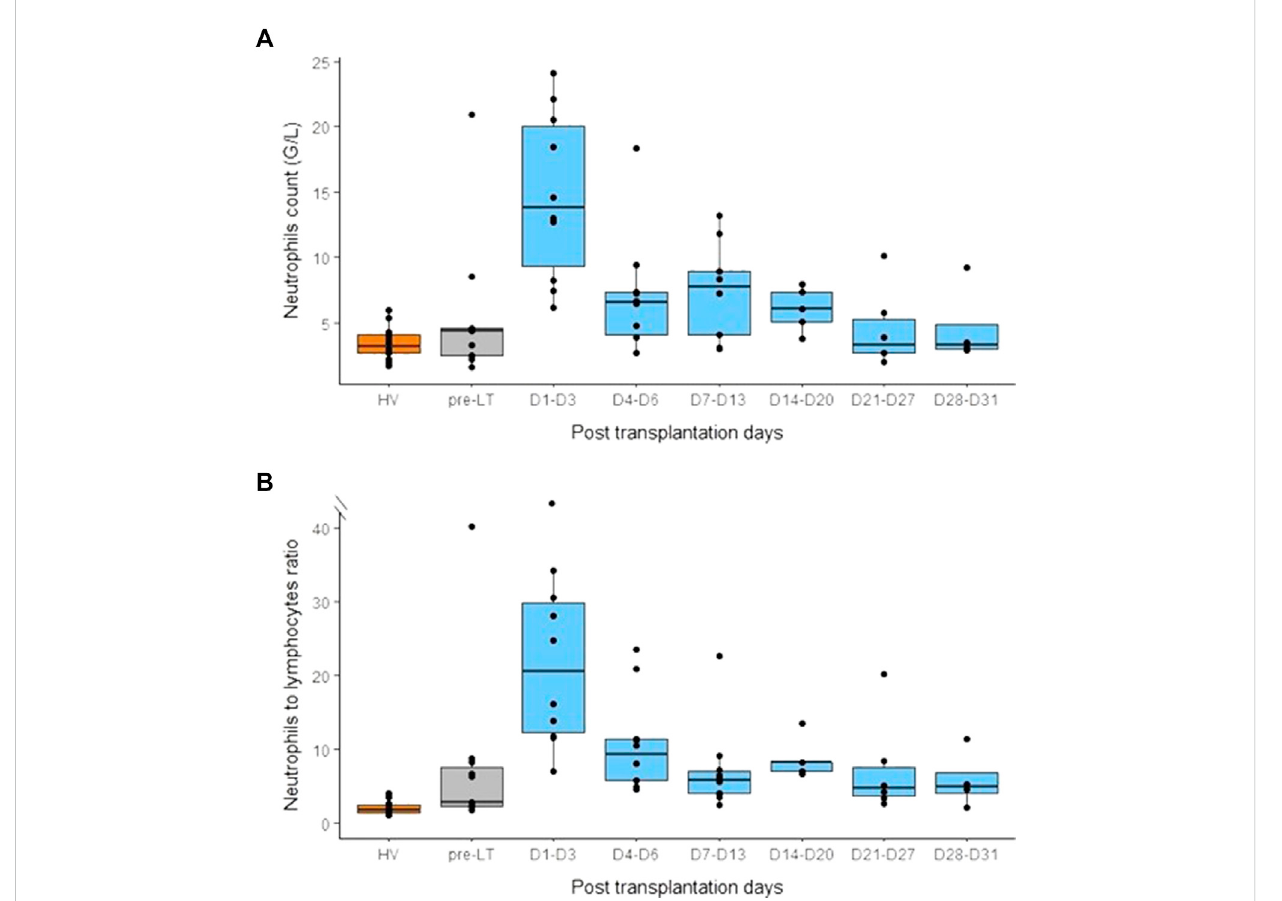
FIGURE 6 Monitoringofneutrophilscountandneutrophilstolymphocytesratio(NLR)beforeandafterlivertransplantation. (A) Neutrophilscountinhealthyvolunteers (HV, n =15),pre-transplantpatients(pre-LT, n =11)andafterlivertransplantationatdifferenttimepoints(day1today3, n =10;day4today6, n =10;day7today 13, n =10;day14today20, n =5;day21today27, n =6;day28today31, n =4). (B) NLRinhealthyvolunteers(HV),pre-transplantpatients(pre-LT)andfollowing transplantation at different time points. Pre-transplant data only concern patients that bene fi ted from